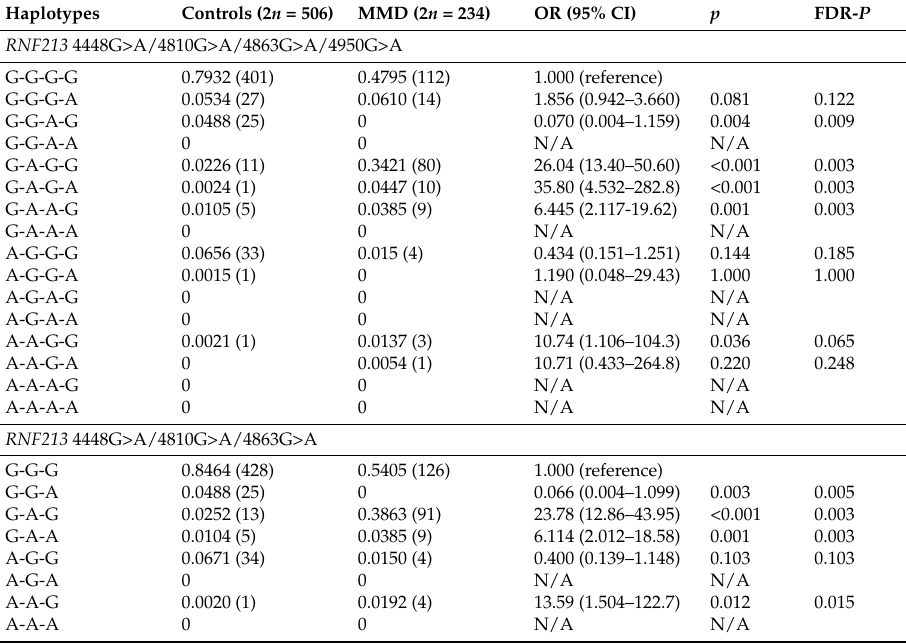
Table 5. Haplotype analysis of RNF213 in MMD patients and control